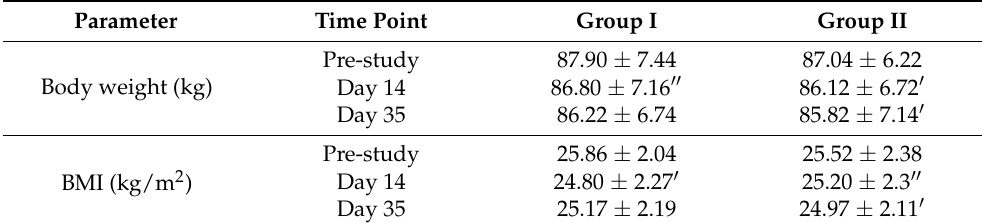
Table 1. Trends in anthropometric parameters of athletes by groups.